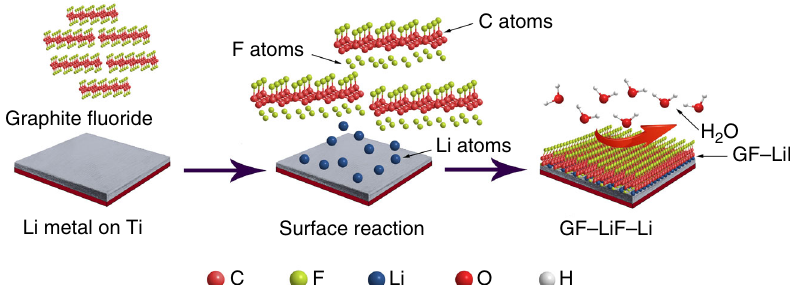
Fig. 1 Schematic illustration of GF – LiF – Li preparation and its protective effect for Li-metal anodes. In the models, the carbon (C), fl uorine (F), lithium (Li), oxygen (O), and hydrogen (H) atoms are displayed as spheres in orange, cyan, blue, red, and white,